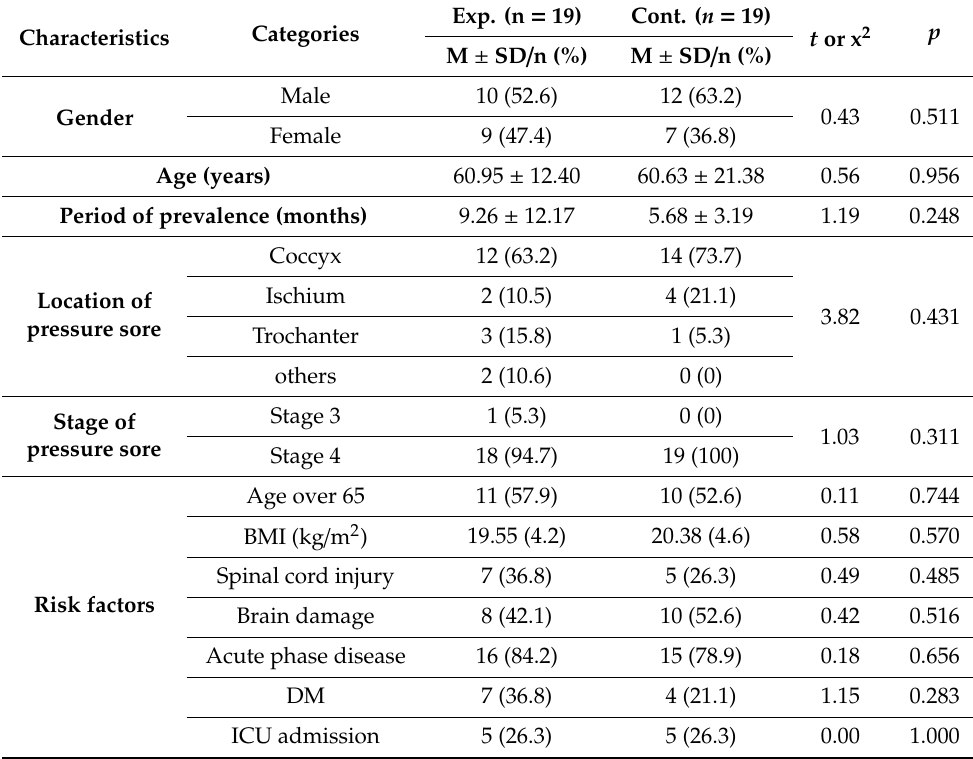
Table 2. General characteristics; the characteristics of patients were simply classified. There were no significant di ff erences between the two groups. Of the initial 49 patients, 11 were excluded, and the remaining 38 patients participated in the